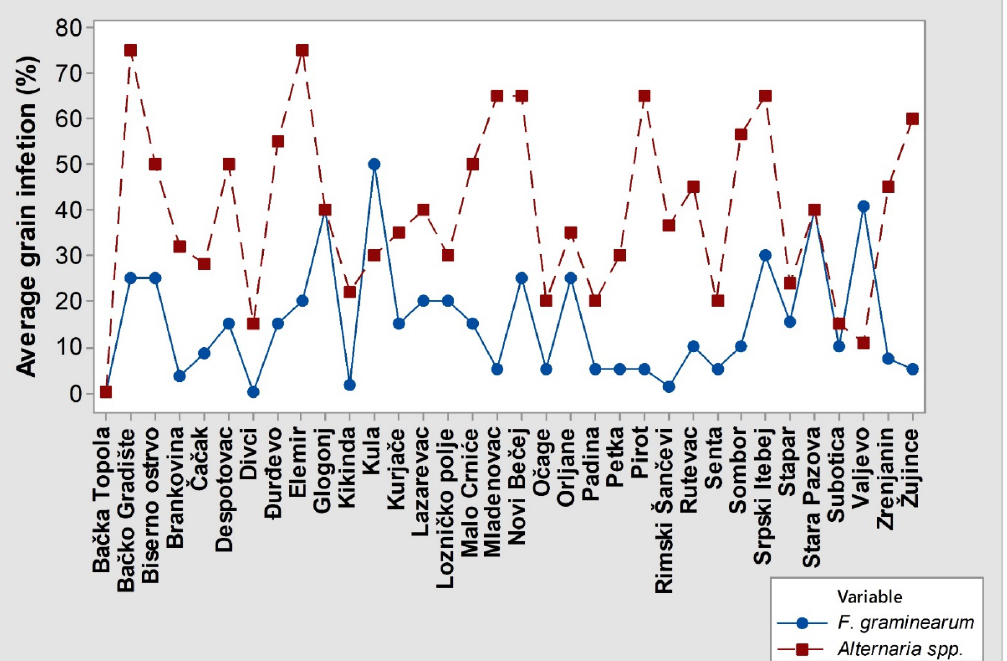
Figure 2. The effect of the location on grain infection with the F. graminearum clade and Alternaria spp. in a three-year period (2017–2019) in Serbia.